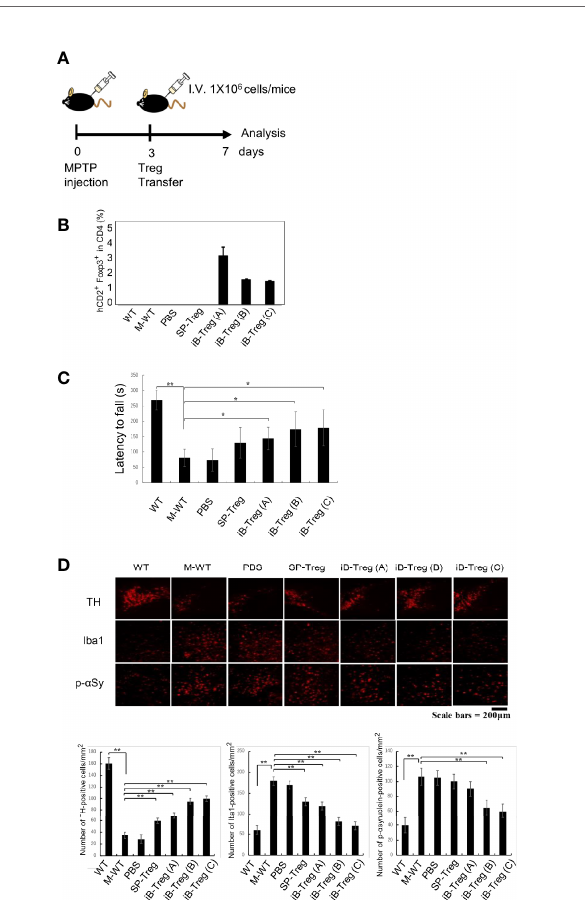
FIGURE 5 | Therapeutic effects of iB-Tregs on a Parkinson ’ s disease model. (A) Parkinson ’ s disease model protocol. After 2 days of training, MPTP (20 mg/kg body weight) was administrated four times every 2 h and Tregs (1×10 6 ) were injected intravenously on day 3 after MPTP treatment and analyzed on day 7. (B – D) MPTP-induced in fl ammation and injury of the substantia nigra. (B) In fi ltrated T cells and Treg cells in the brain of MPTP- treated mice were analyzed using FACS, and the fraction of Foxp3 + hCD2 + cells in the brain were estimated. (C) The rod test score for MPTP-treated mice in control, PBS-transfected (PBS), splenic Treg-transfected (SP-Treg), and iB-Treg-transfected (A – C) groups. (D) Dopaminergic neurons were stained with anti-TH antibody, activated microglia cells were stained with anti- Iba1(Iba1) antibody, and neural damage was stained with anti-p- a Synuclein antibody, and the images were quanti fi ed. * P<0.05 ** P<0.01.